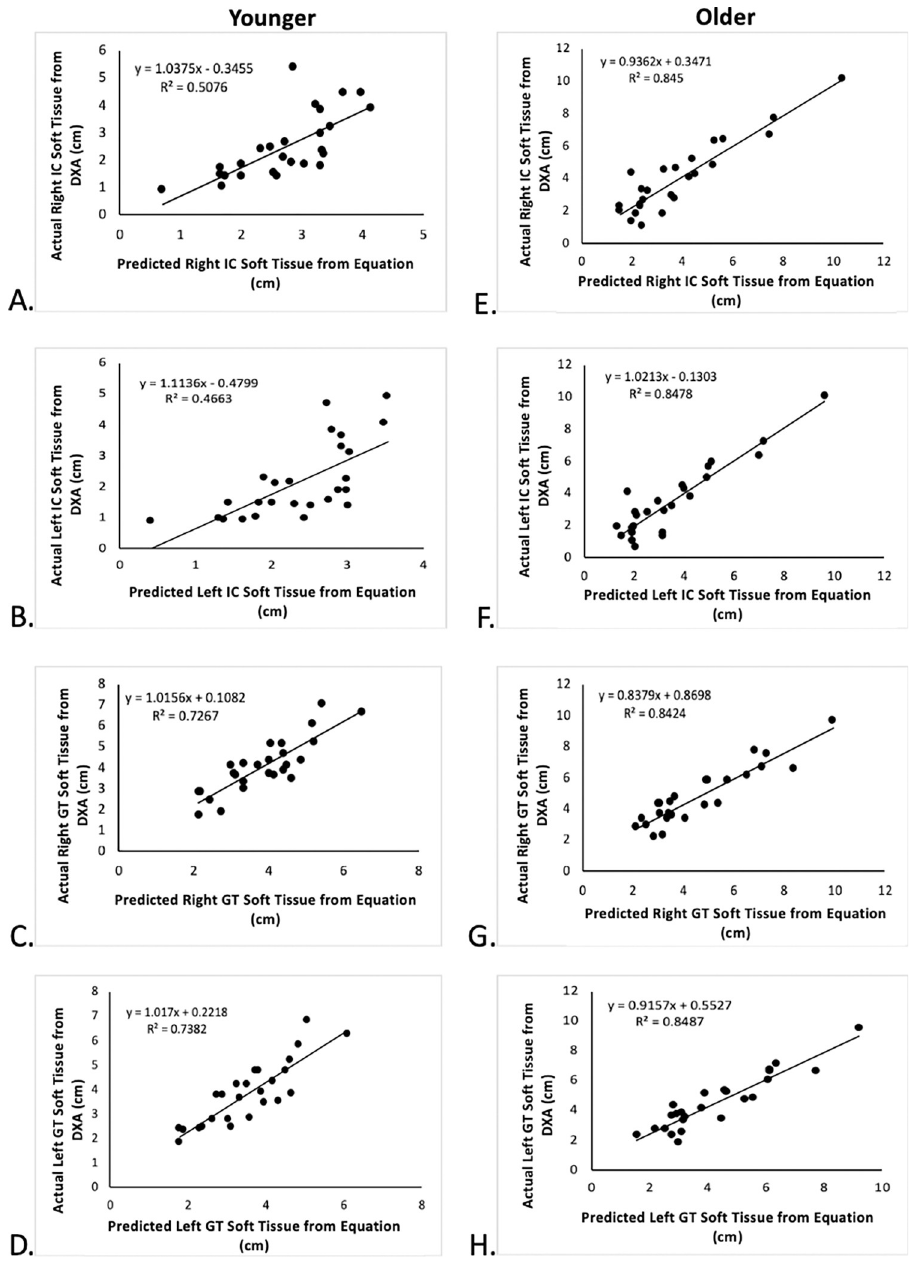
Fig 1. Relationship between predicted and actual soft tissue thicknesses. Soft tissue thickness of the younger population’s right IC (A), left IC (B) right GT (C), left GT (D); and the older population’s right IC (E), left IC (F) right GT (G), left GT (H). DXA = Dual X-Ray Absorptiometry; cm = centimeters; IC = Iliac Crest; GT = Greater Trochanter. equations created for the older population had higher R 2 values (0.819 to 0.852) in comparison to the younger population (0.704 to 0.791). Pearson correlations between the predicted and actual soft tissue thicknesses measured by DXA were statistically significant for all equations and high in general (Fig 1), with R 2 values ranging from 0.466 to 0.738 for the younger group and 0.842 to 0.848 for the older group.